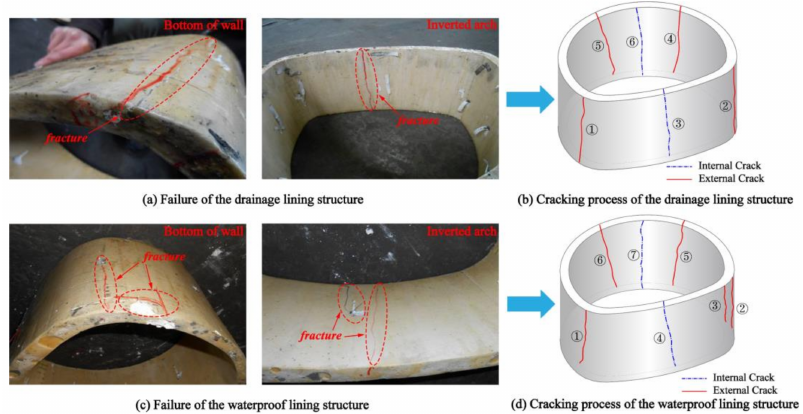
Figure 16. Failure of the lining